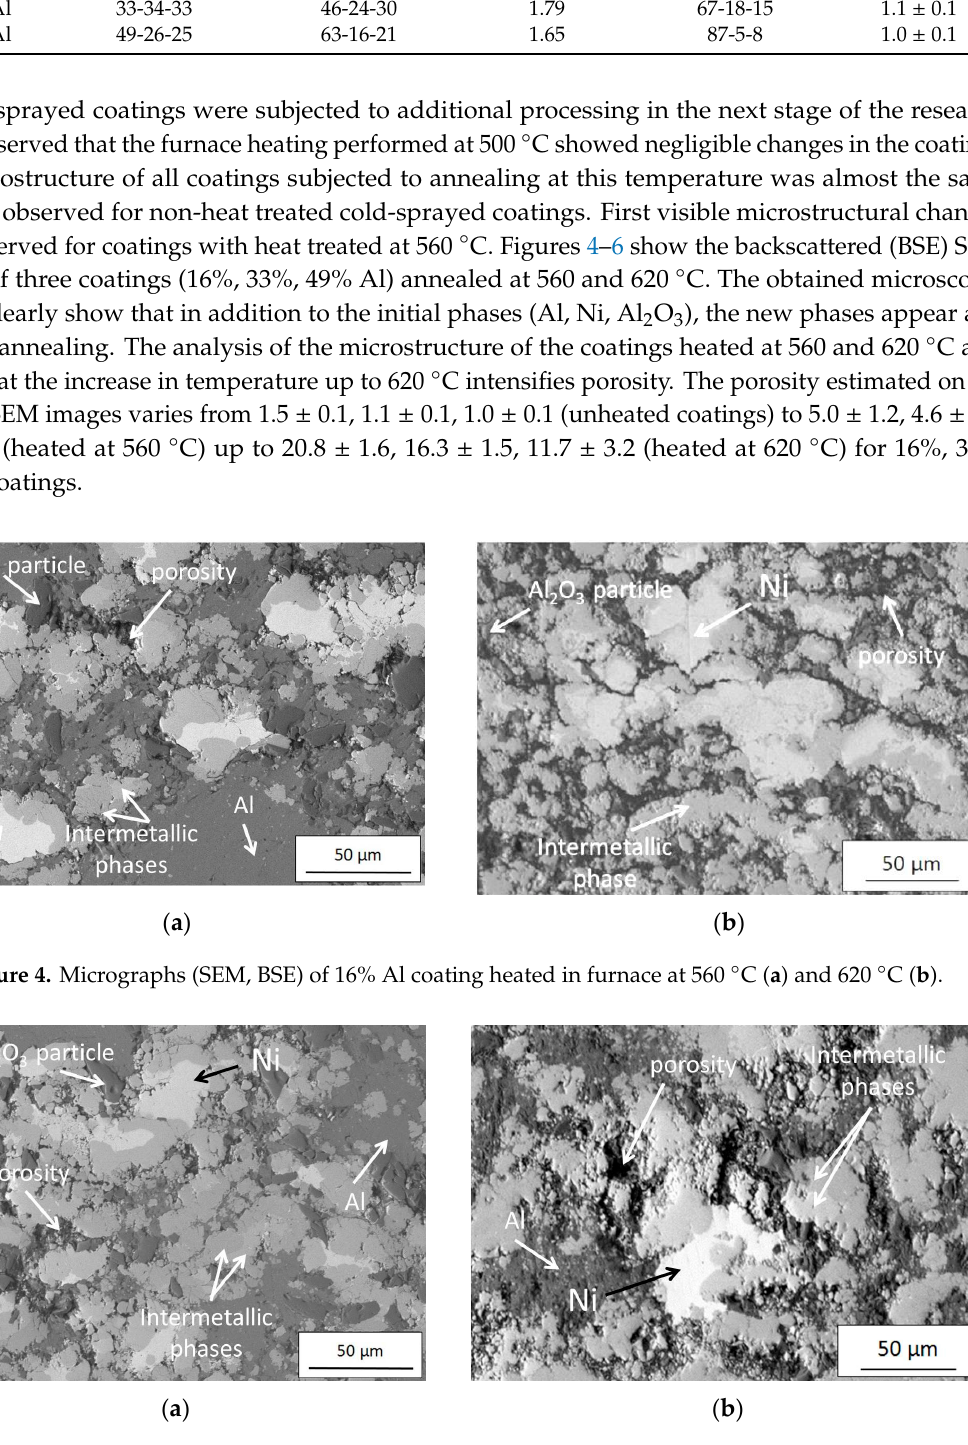
( a ) ( b ) Figure 6. Micrographs (SEM, BSE) of 49% Al coating heated in furnace at 560 °C ( a ) and 620 °C ( b ). In the next step of the research, how the microstructure of the final coatings will be affected by a process completely different from the conventional furnace heating was tested. Therefore, the coatings were subjected to resistance spot welding. As one might have supposed, samples heat- treated by the resistance spot welding process showed various microstructures depending strongly on process parameters (Table 2). The single-pulse resistance spot welding (parameters No. 1 and 2) revealed no changes in the microstructure of coatings compared to the microstructure before welding. The double-pulse spot welding (parameters No. 3) visibly causes a slight increase in porosity from 1.5 ± 0.1, 1.1 ± 0.1, 1.0 ± 0.1% (in unheated 16% Al, 33% Al, 49% Al coatings) to 3.1 ± 0.6, 2.9 ± 0.5, 1.2 ± 0.2% (Figures 7a, 8a and 9a). However, the analysis of SEM images does not allow us to find any sign of an intermetallic phase in the microstructure of these coatings. In contrast, double- pulse spot welding with parameters No. 4 led to the intensive formation of intermetallic phases (Figures 7b, 8a and 9b) and an increase of porosity to 4.6% ± 2.1%, 4.2% ± 0.7%, 3.7% ± 0.8% in 16% Al, 33% Al and 49% Al coatings, respectively. The resistance spot welding process causing compaction of the coating and as a result all of the coating structures, independently on the powder mixture, was very similar in comparison to furnace heating. Some local porosity was only visible around alumina particles, which were probably crushed while spraying. Intermetallics were formed in the weld region equal to the electrode’s diameter. The reaction was stopped at the boundary of the weld (Figure 10). However, thermal conductivity caused the distribution of intermetallics in the nearest region outside the weld. In the weld region, aluminium diffused and almost completely reacted with nickel, forming intermetallic phases. Moreover, as a result of resistance heating, the temperature was highest in the coating-substrate boundary region and thus the Al-Ni reaction was most intensive next to the substrate. Figure 11 shows a comparison of the microstructure of a 16% Al coating treated by heating at 620 °C in a furnace (Figure 11a) and by resistance spot welding (Figure 11b) (parameters No. 4). This